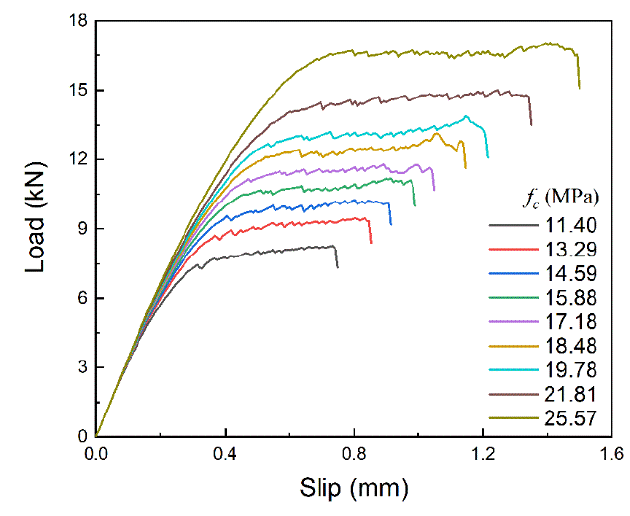
Figure 19. Load-slip curves with different brick strength.